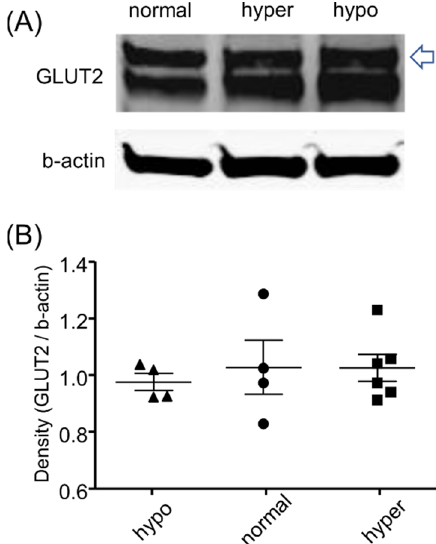
Figure 6. GLUT2 expression in renal cortical tissues assessed by Western blot. ( A ) Representative blots and ( B ) quantitative data are shown ( n = 4–6). There are two bands for GLUT2; one is mem- brane-bound form and another is cytosolic form. The bands that are indicated by an arrow, which are detectable mainly in the cell membrane (glycosylated), were analyzed. Hypo: hypoglycemia, normal: normoglycemia, hyper: